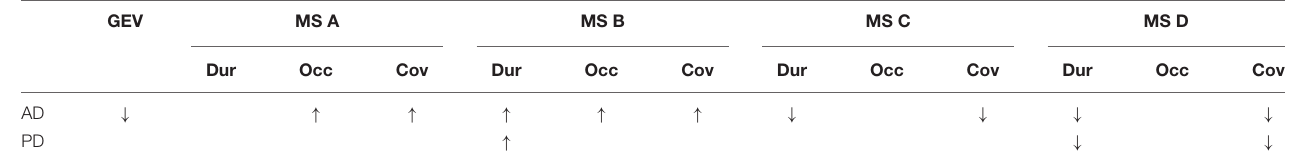
TABLE 4 | The statistics results of the microstate parameters which are global explained variance (GEV), duration (Dur), occurrence (Occ), and coverage (Cov) in AD and PD